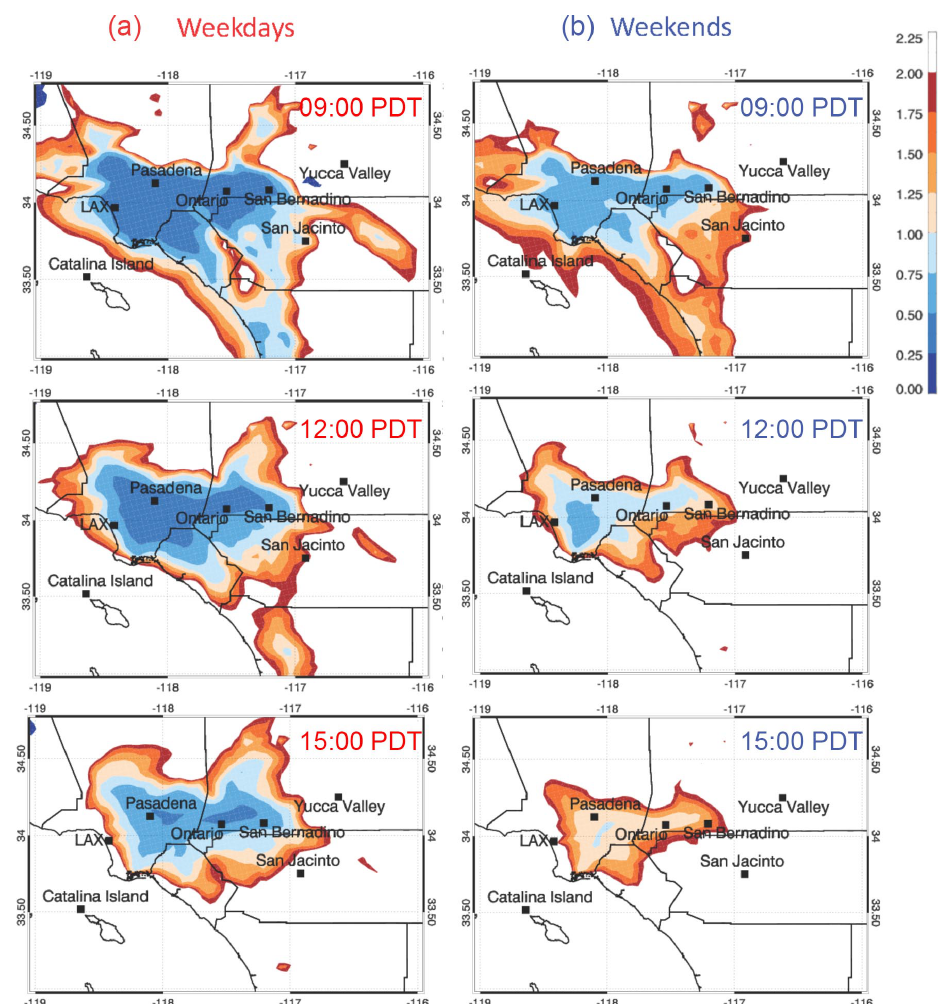
Figure 9. Spatial distributions of the ratios of the model HCHO column to NO 2 column during weekdays (a) and weekends (b) at 09:00, 12:00, and 15:00PDT for May–June 2010. The light pink to red colored contours denote the area under the NO x -limited chemical